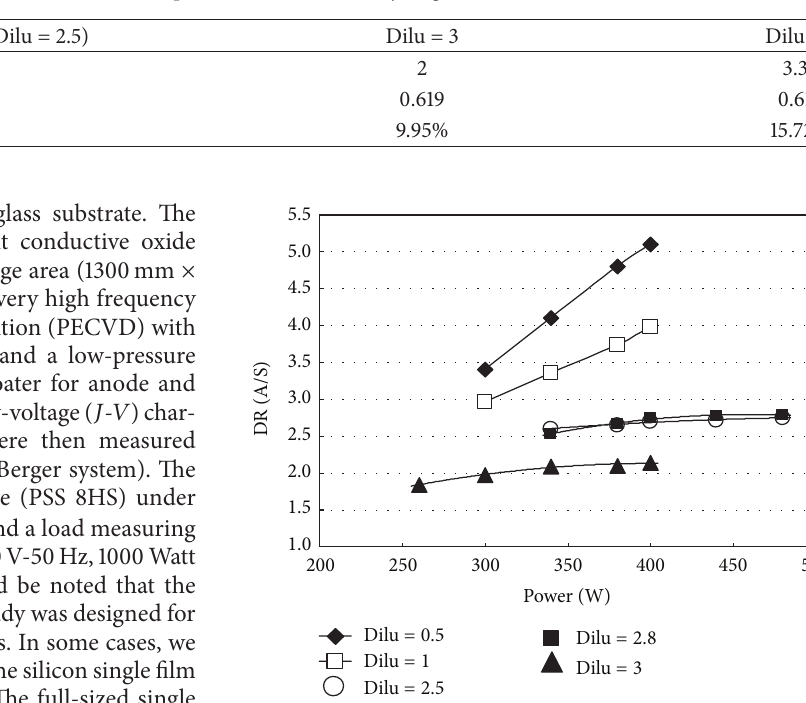
Table 1: A more detailed comparison between samples with two different hydrogen dilution ratios (i.e., 3 and 1).